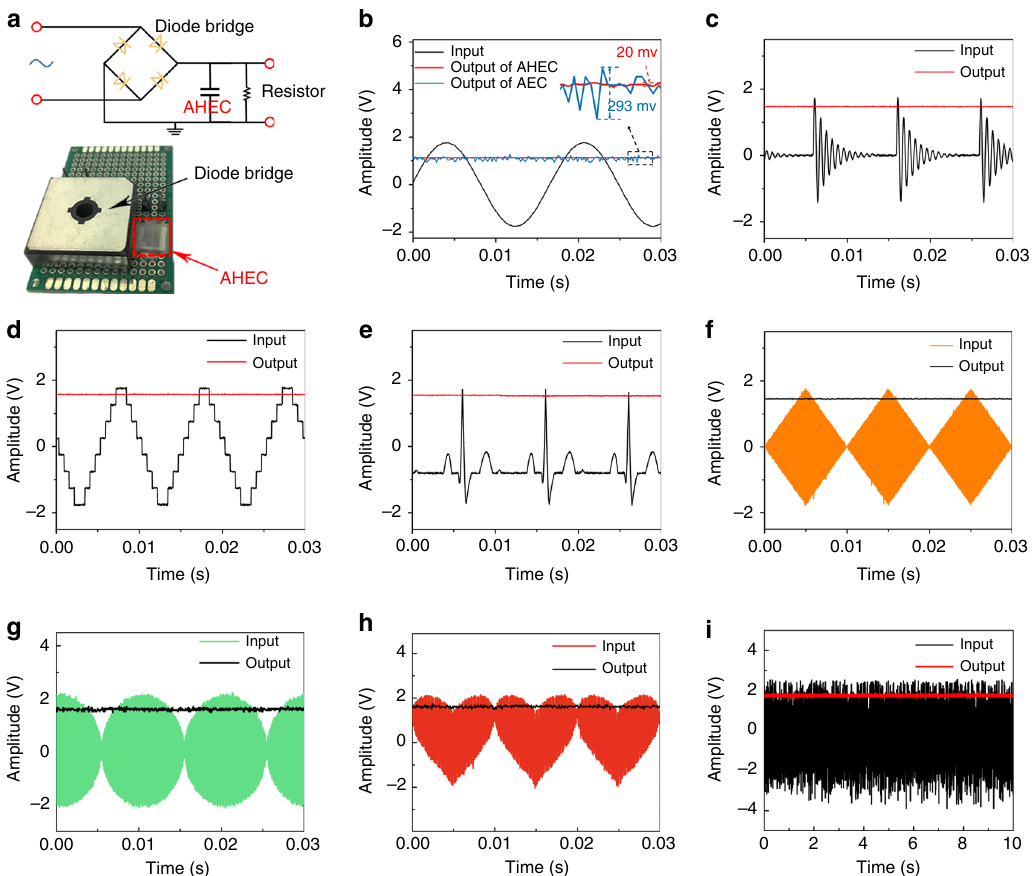
Fig. 4 The fi ltering performances of unit. a Schematic: demonstration of this circuit for fi ltering circuit; optical image: the aqueous hybrid electrochemical capacitor (AHEC) and diode bridge on the board circuit for smoothing AC signals. b Comparison of AC line- fi ltering performances of the AHEC with the commercial AEC at 60 Hz. c – i The fi ltering performances of the AHEC unit for arbitrary waveforms. The input signals are decaying ( c ), stair ( d ), electrocardiogram ( e ), rhombus ( f ), ellipse ( g ), heart ( h ), and violent noise waveforms ( i ). The frequency of c to h is 100 Hz. Source data are provided as